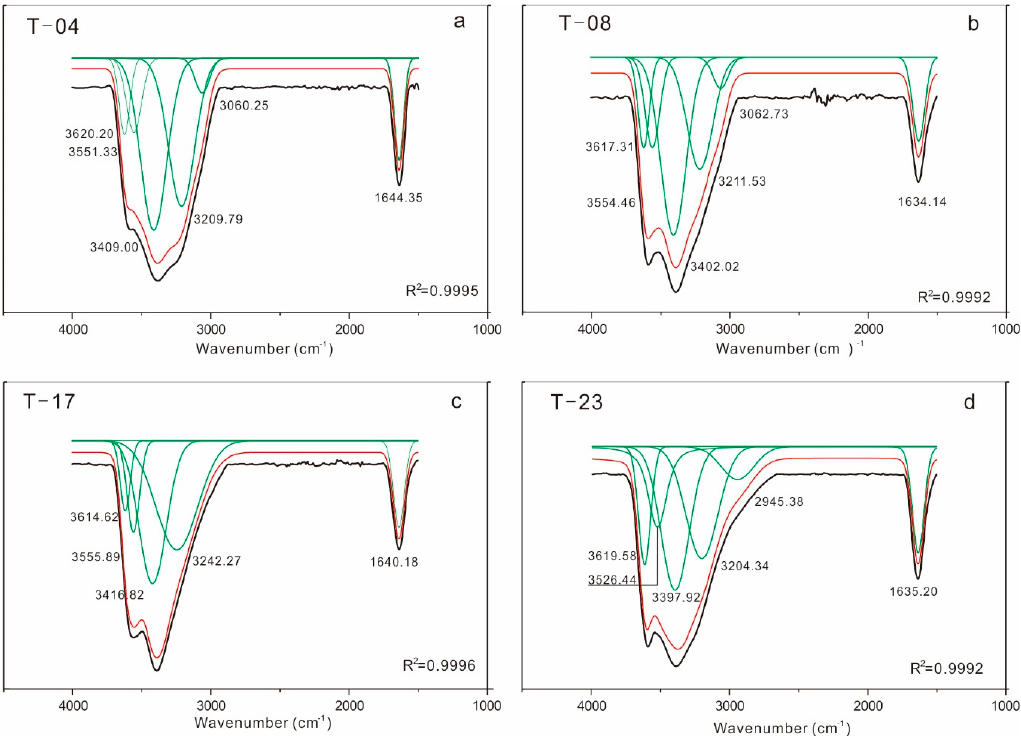
Figure 4. Decomposition of the MIR bands in the high-frequency area of four samples ( a ) T-04, ( b ) T- 08, ( c ) T-17, and ( d ) T-23. Black lines: experimental spectra; green lines: individual bands; red lines: fitted curves. Minerals 2019 , 9 , x FOR PEER REVIEW